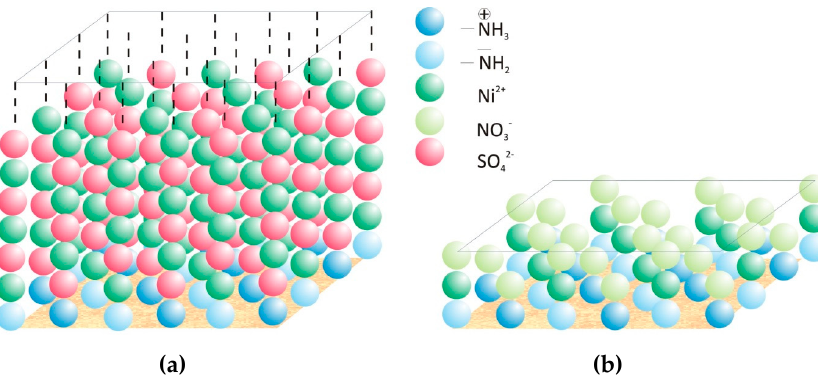
Figure 8. Schematic depiction of the adsorption mechanisms of nickel cations on chitosan surface. Adsorption of nickel from ( a ) nickel sulfate solution and ( b ) nickel nitrate solution.